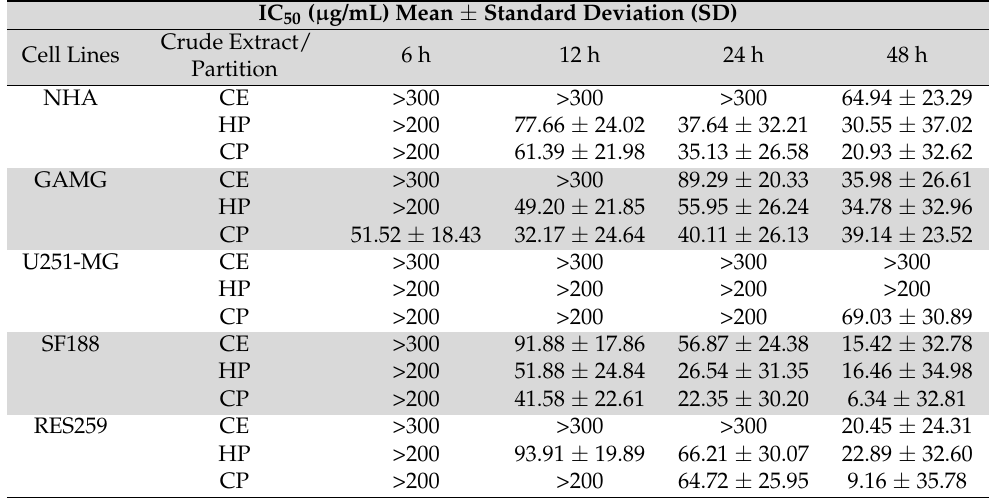
Table 5. IC 50 values for crude leaf extract and partitions from Miconia chamissois